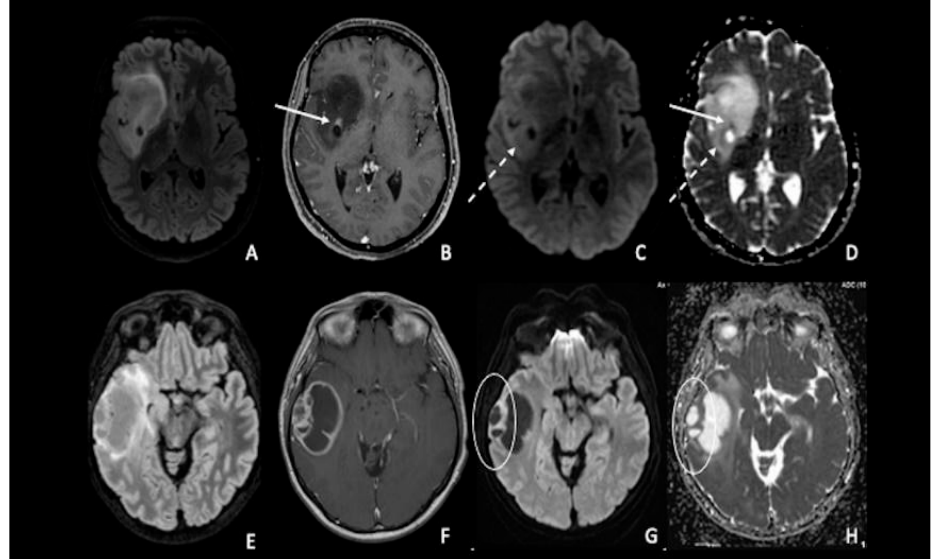
Figure 2. ( A – D ) IDH-1 mutated glioma in the right Sylvian region. The lesion is characterized by a heterogenous signal on FLAIR ( A ), with a small area of nodular enhancement on post-contrasto- graphic T1 weighted images (arrow) ( B ); The site of pathological enhancement was in close proximity to an area of cystic-necrotic degeneration (dotted arrow) ( C , D ) and showed restricted diffusion on DWI confirmed by the ADC map (arrow); these findings were consistent with an anaplastic behavior of the tumor. ( E – H ) Right temporal lobe glioblastoma. The lesion was predominantly cystic and had a vivid peripherical post-contrastographic enhancement ( F ) with a solid component on the lateral side of the tumor; this region presented restricted diffusion on DWI confirmed by the ADC map (circle) ( G , H ), related to an increase in tumor cellularity. FLAIR = fluid-attenuated inversion recovery; DWI = diffusion-weighted imaging; ADC = apparent diffusion coefficient.